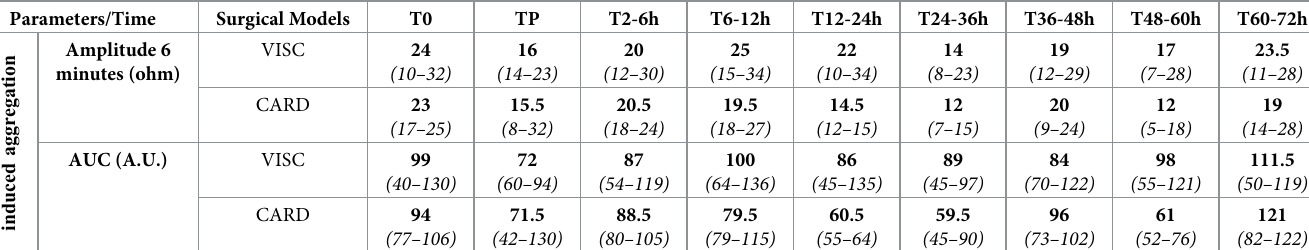
Table 3. Platelet aggregometry